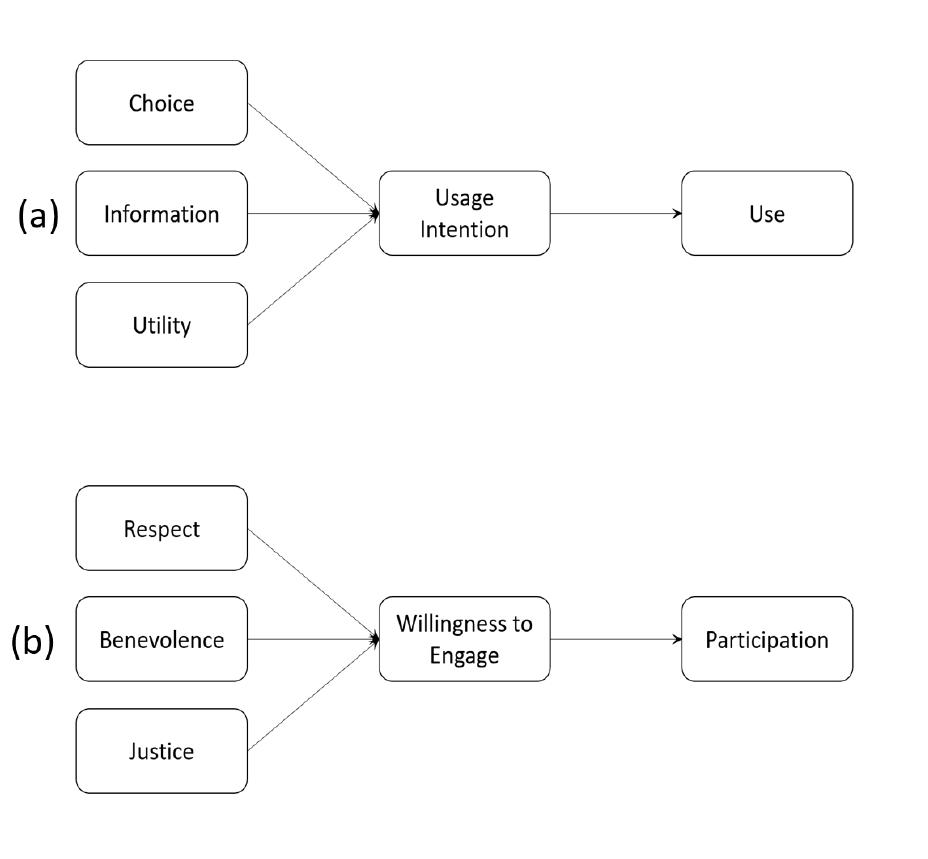
Figure 2. TPB Interpretation of Behaviours associated with ( a ) Terms of Use and ( b ) Research Consent